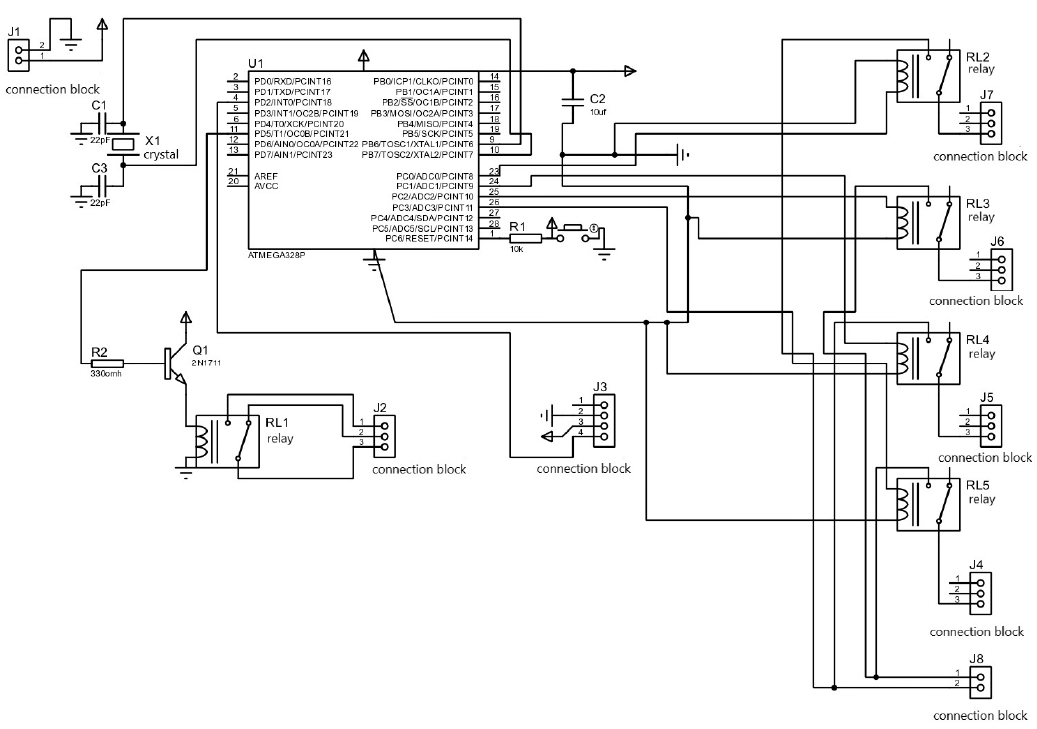
Figure 6. Control circuit for the mechanical system responsible for processing signals, emitting pulses, controlling relays, and switching operating mode.